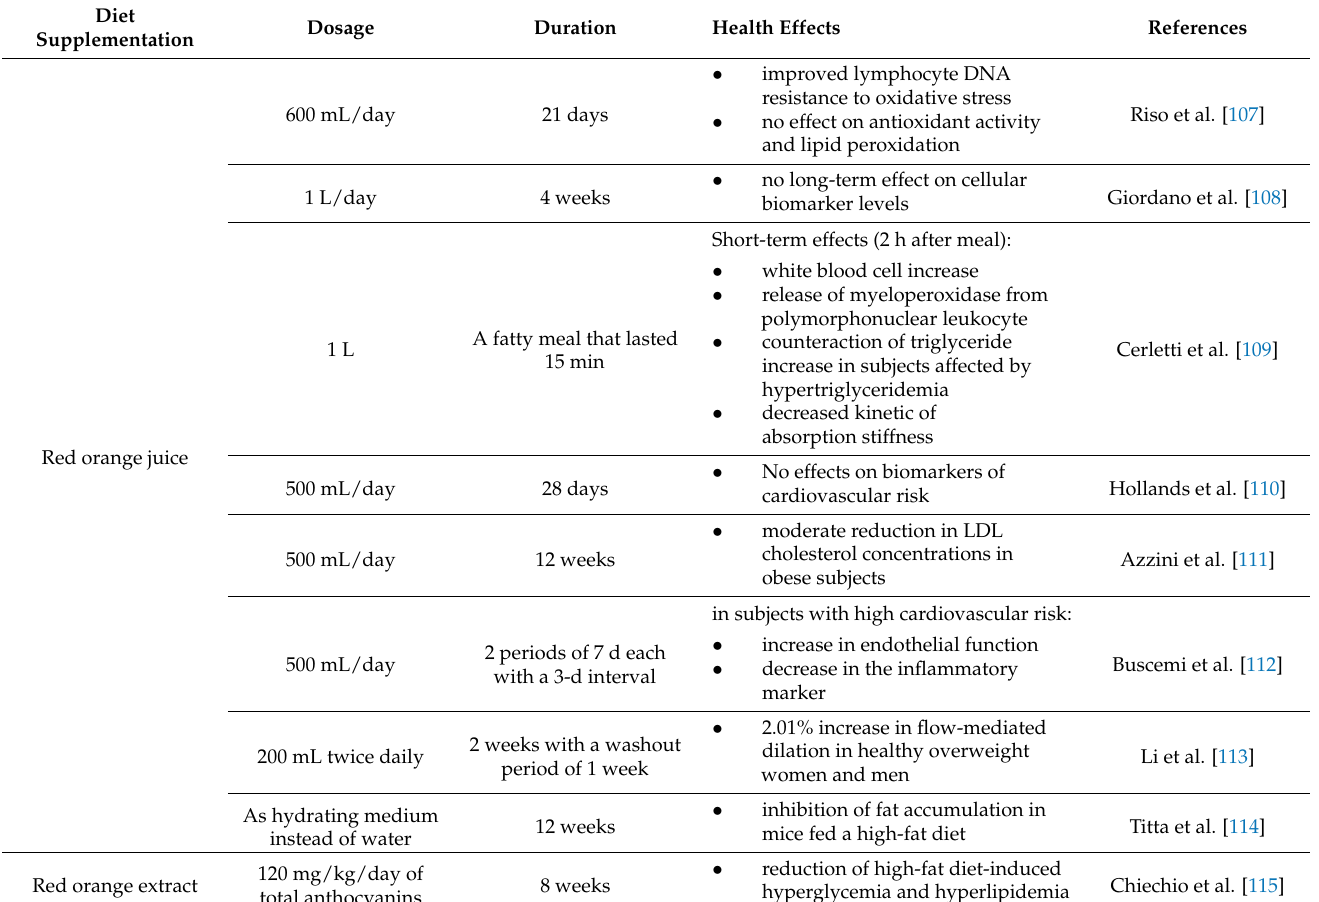
Table 2. In-vivo intervention studies carried out by supplementation of citrus anthocyanins and their relevant health